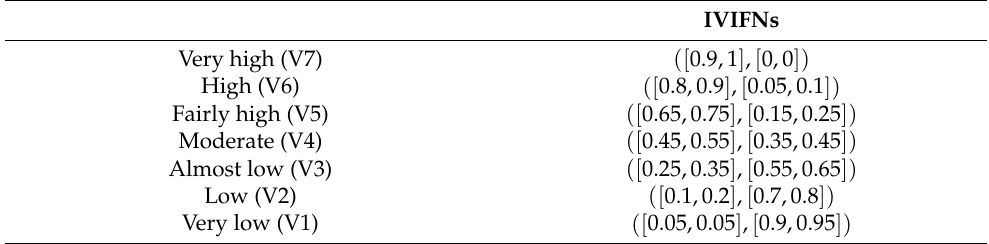
Table 4. The performance indicators’